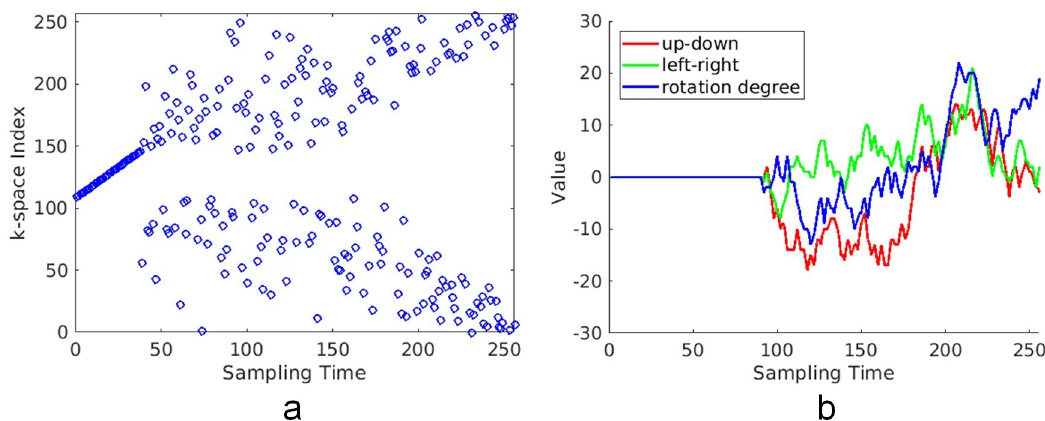
Fig 2. Examples of sampling order and motion track for motion-corrupted image synthesis. (a) An example of the pseudo- random sampling order used in image synthesis. The center 15% of the k-space was sequentially sampled first. Then, the remaining phase-encoding (PE) lines were sampled randomly with a Gaussian distribution, until all 256 lines were sampled. (b) One motion track was used in the simulation. The horizontal axis represents the sampling time, expressed as the number of sampled lines. The vertical axis indicates the amount of translation (unit: pixel) and the rotation (unit: degree). In this motion mode, the object remained still for the first 35% of the total sampling time. Then, a random translation in the range of ± 5 pixels and a random rotation in the range of ± 5 degrees were applied after each PE line was sampled.